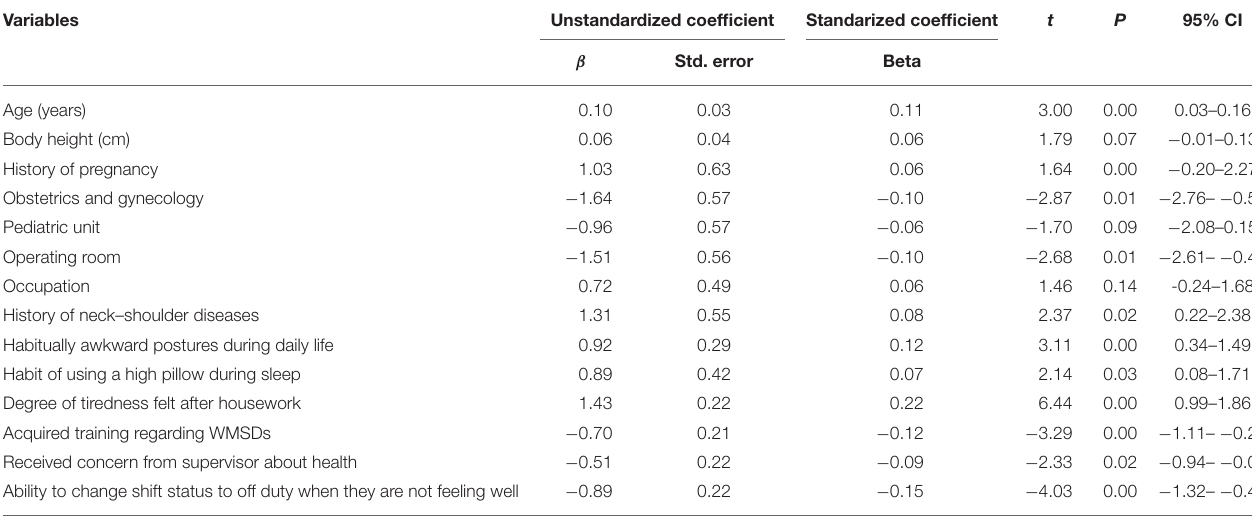
TABLE 2 | Factors related to neck-shoulder pain in healthcare workers: linear regression analysis.